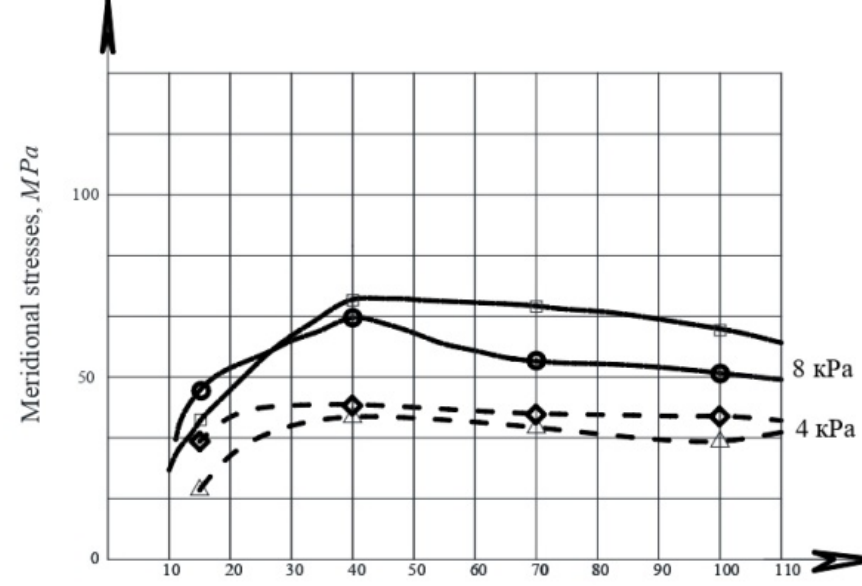
Figure 6. Distribution of the meridional stresses in the joint zone with the wall bend in the joint equal to 30 mm and 50 mm.